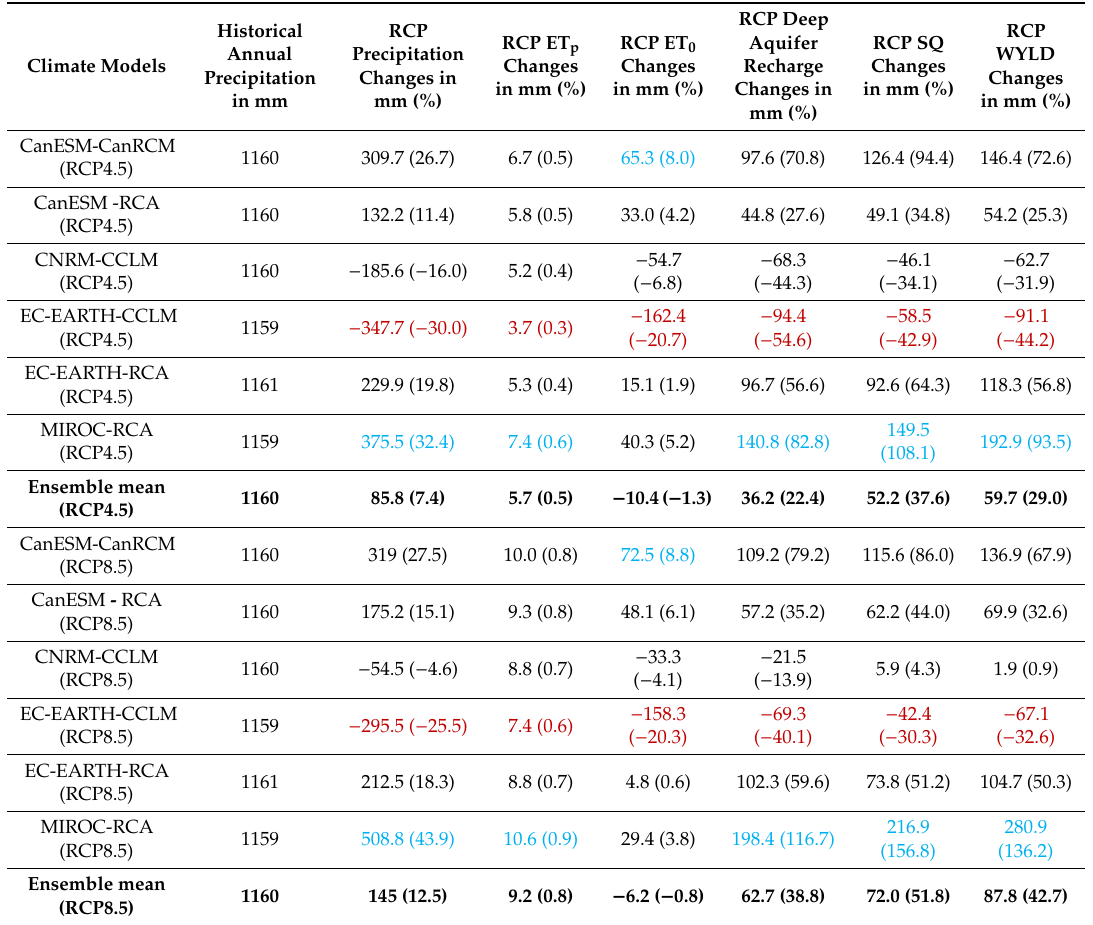
Table 3. Projected changes in selected water balance components simulated for the period 2021–2050 based on RCP4.5 and RCP8.5 scenarios relative to the period 1976–2005. Historical annual average precipitation is based on bias-corrected RCM simulations (1976–2005). For each water balance component (except the historical precipitation) and RCP scenario, the highest and lowest values based on the absolute changes are highlighted in light blue and red, respectively. ET p represents potential evapotranspiration, ET 0 is the actual evapotranspiration, SQ is surface runo ff , and WYLD is the overall water